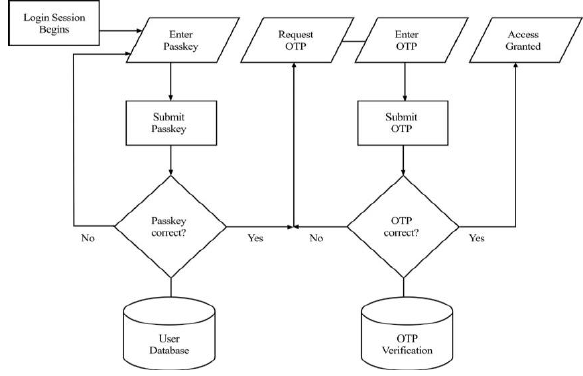
Fig. 3. Multifactor authentication flowchart